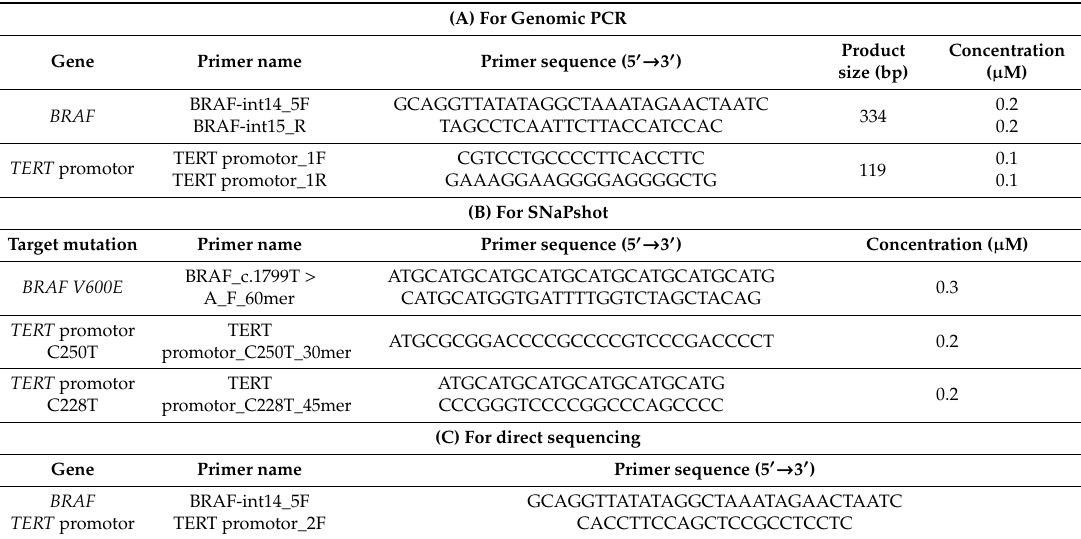
Table 7. Primer sequences and concentrations for